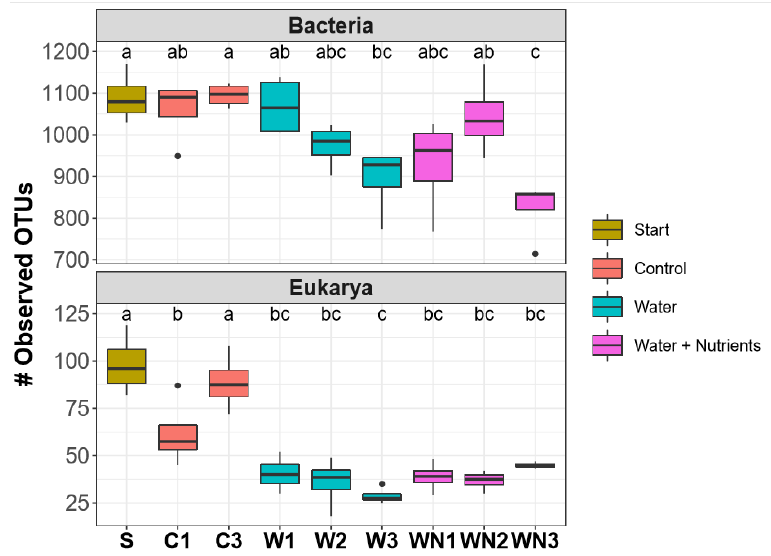
Figure 4. Alpha diversity (Operational Taxonomic Unit (OTU) richness) box plots for eukaryotic and bacterial communities in the microcosm experiment. Upper Panel: Bacterial community. Significant decrease in alpha diversity after 3rd water addition (Tukey’s HSD p < 0.05). Lower Panel: Eukaryotic community. Significant decrease in alpha diversity after 3rd water addition and in all water + nutrient additions (Tukey’s HSD p < 0.05). The dark horizontal line inside the box represents the median. The long vertical black lines for each box represent the maximum and minimum values of OTU richness and circles represent outliers. Boxes with same letter are not significantly different. Different letters represent significant differences among treatments (Tukey’s HSD p < 0.05). Note the difference in the y -axis scale between the two panels.